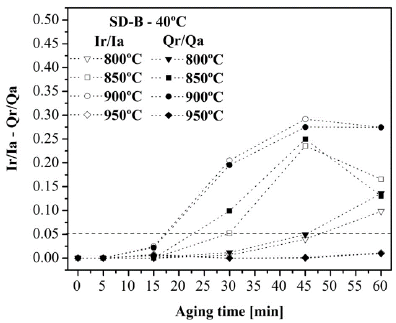
Figure 6. I + 0.01 M KSCN + 0.50 M NaCl solution test at 40